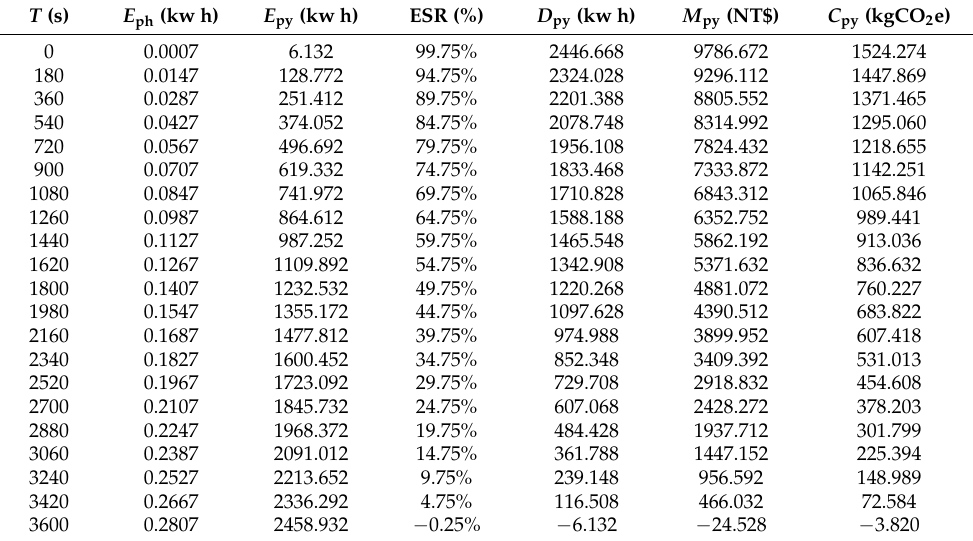
Table 3. Electric energy ( E ph ), annual electric energy ( E py ), energy-saving rate (ESR), annual electricity consumption ( D py ), annual cost ( M py ) and annual carbon emission reduction ( C py ) values of each fan with different average hourly start-up ( T )